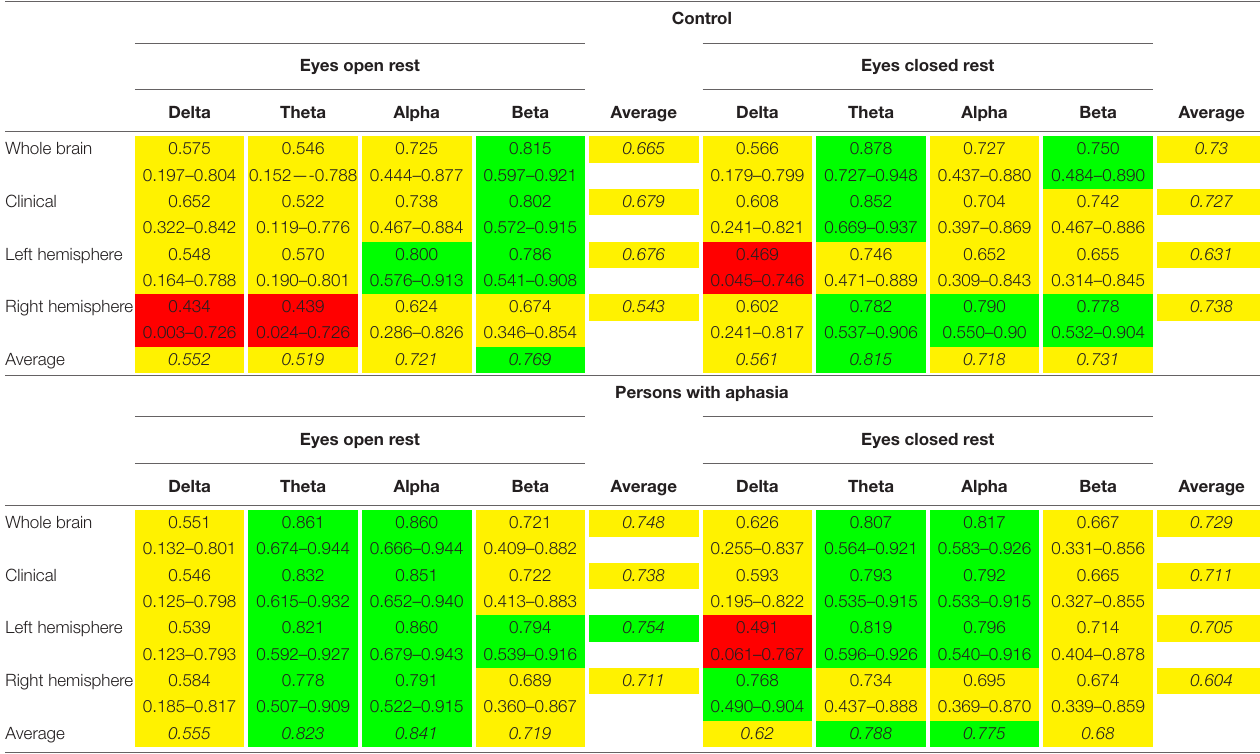
TABLE 3 | Intra-class correlation coefficients and 95% confidence intervals for neurologically healthy controls and persons with